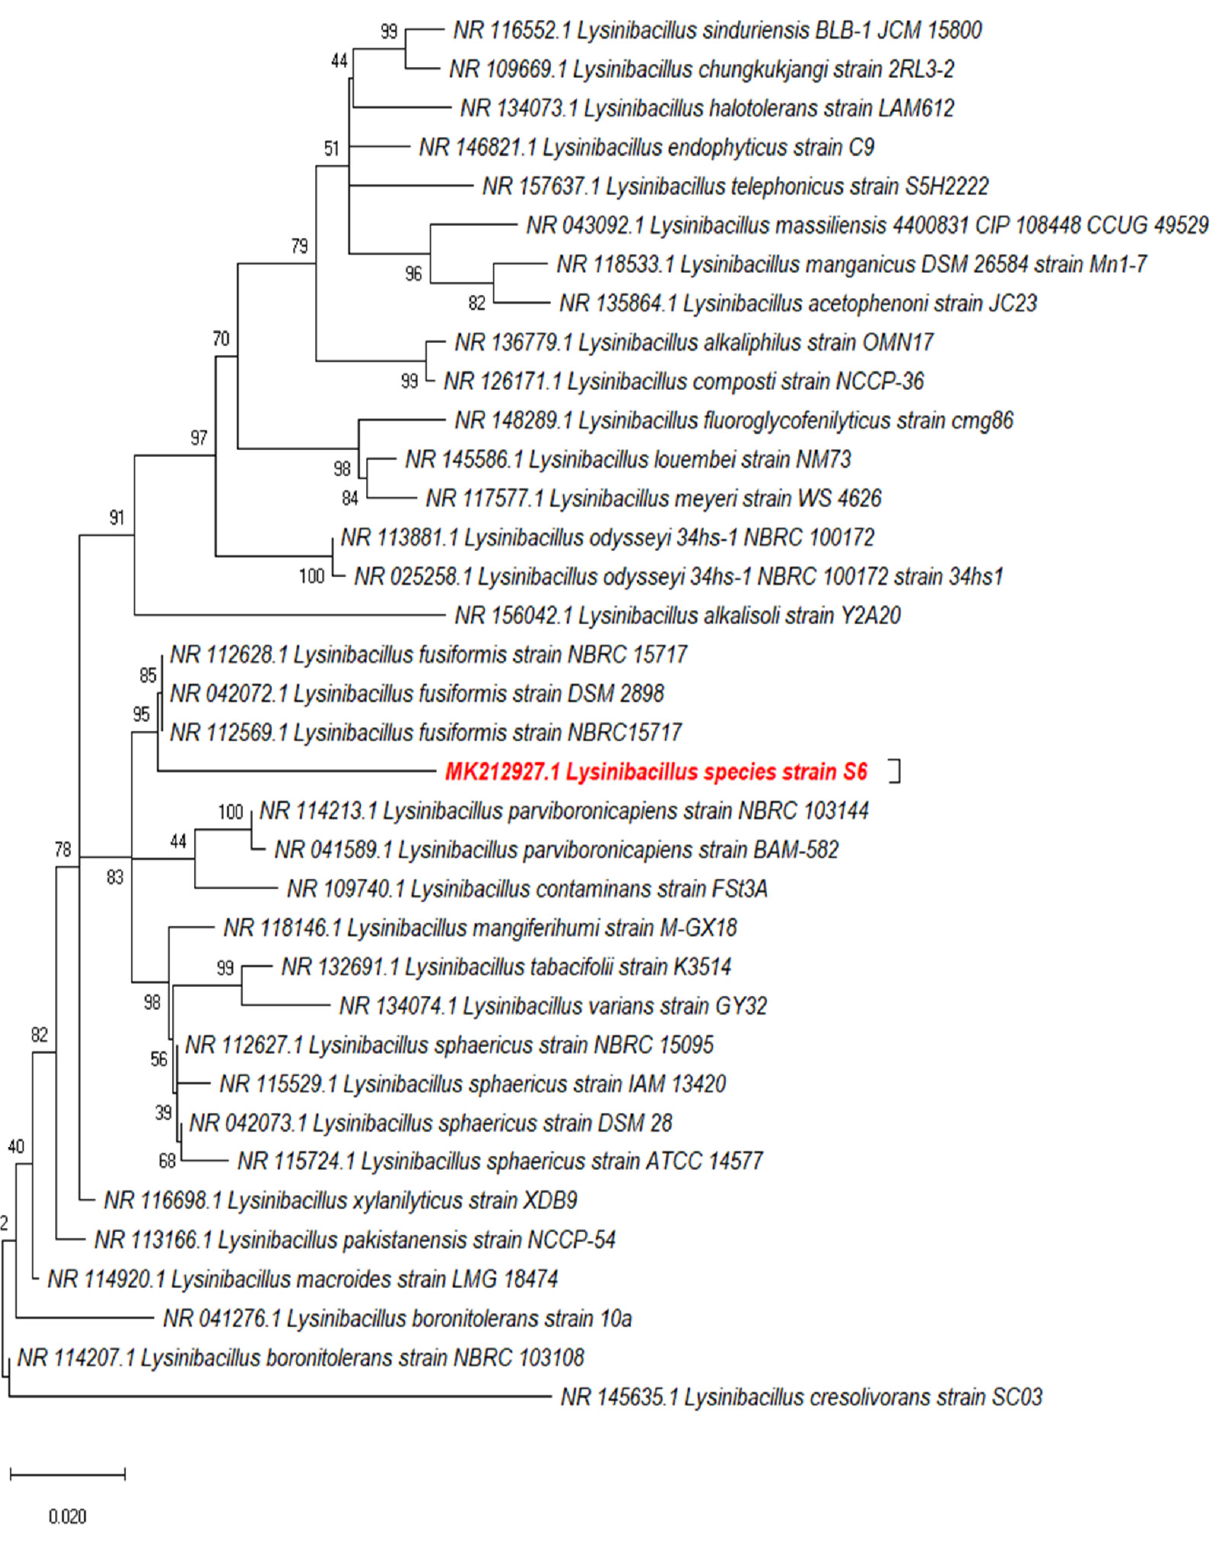
Figure 1. Molecular phylogenetic analysis of the query isolate (S6) using maximum likelihood method based on the Kimura 2-parameter model in MEGA X.